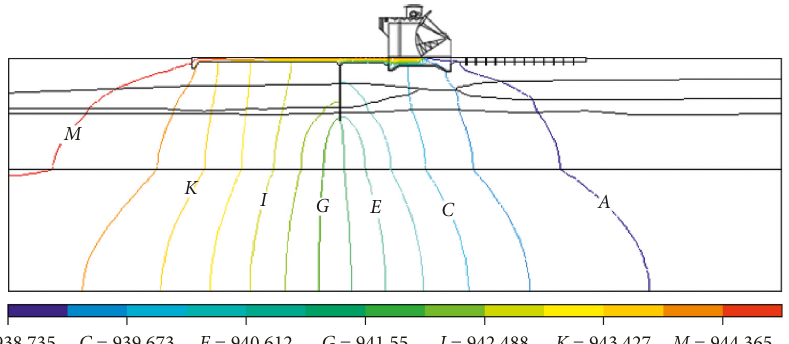
Figure 20: Total seepage head contour in 1# sluice foundation in flood season.